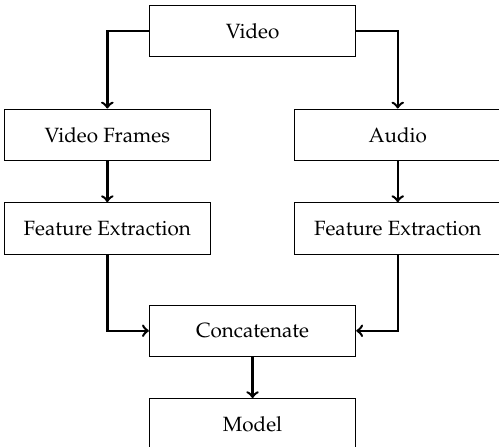
Figure 6. Early fusion. Illustration of how audio-visual features can be created. A ResNet is used to compute visual features based on single frames. For the audio, a Log-Mel spectrogram is used to train a 2D-ResNet and further used as a feature extractor by removing the output layer. These features are then concatenated.